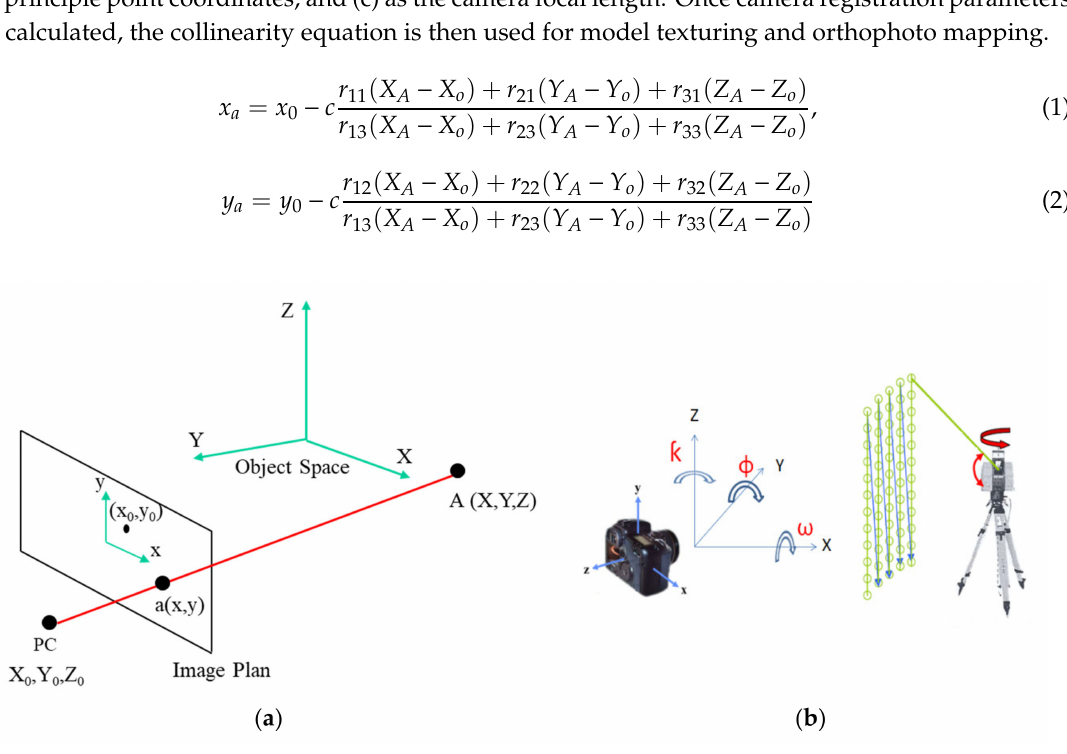
Figure 5. ( a ) Collinearity projection model; ( b ) camera registration